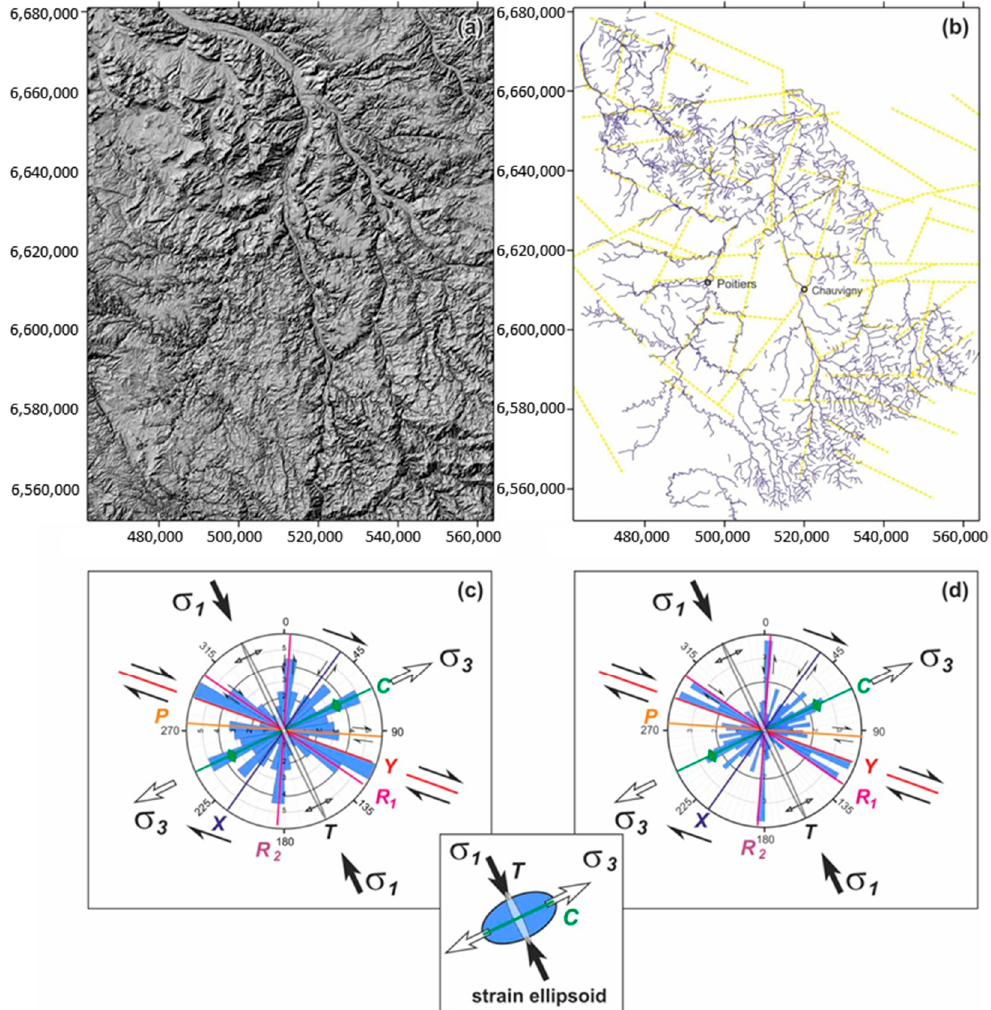
Figure 6. ( a ) Shaded-relief elevation and ( b ) drainage patterns in the area of the Vienne Department. ( c , d ) show drainage segment orientations in the rose diagrams with differentially assigned petal widths (10° and 5°, respectively). ( b ) Yellow dashed lines correspond to morpholineaments extracted from a shaded-relief elevation visualization model. The lowermost detail demonstrates a neotectonic strain ellipsoid orientation responsible for the formation of the recent drainage network.